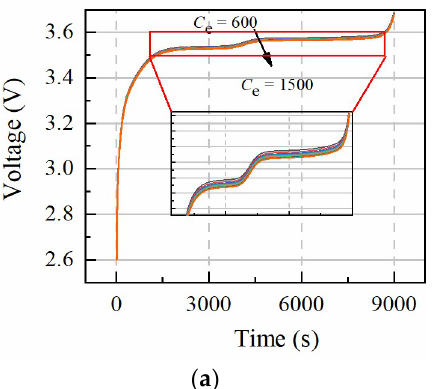
sitivity curves under 0.5 C charging rate; ( b ) Sensitivity curves under 1 C charging